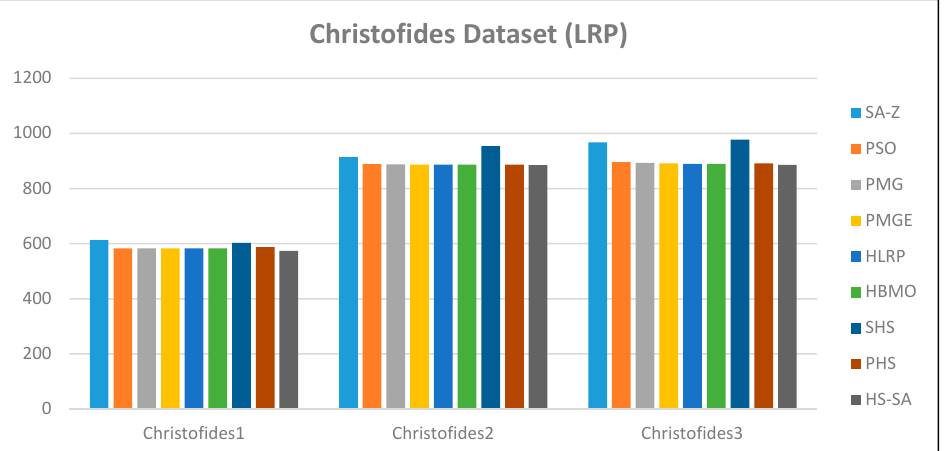
Figure 5. Best result of Christofides dataset for LRP.